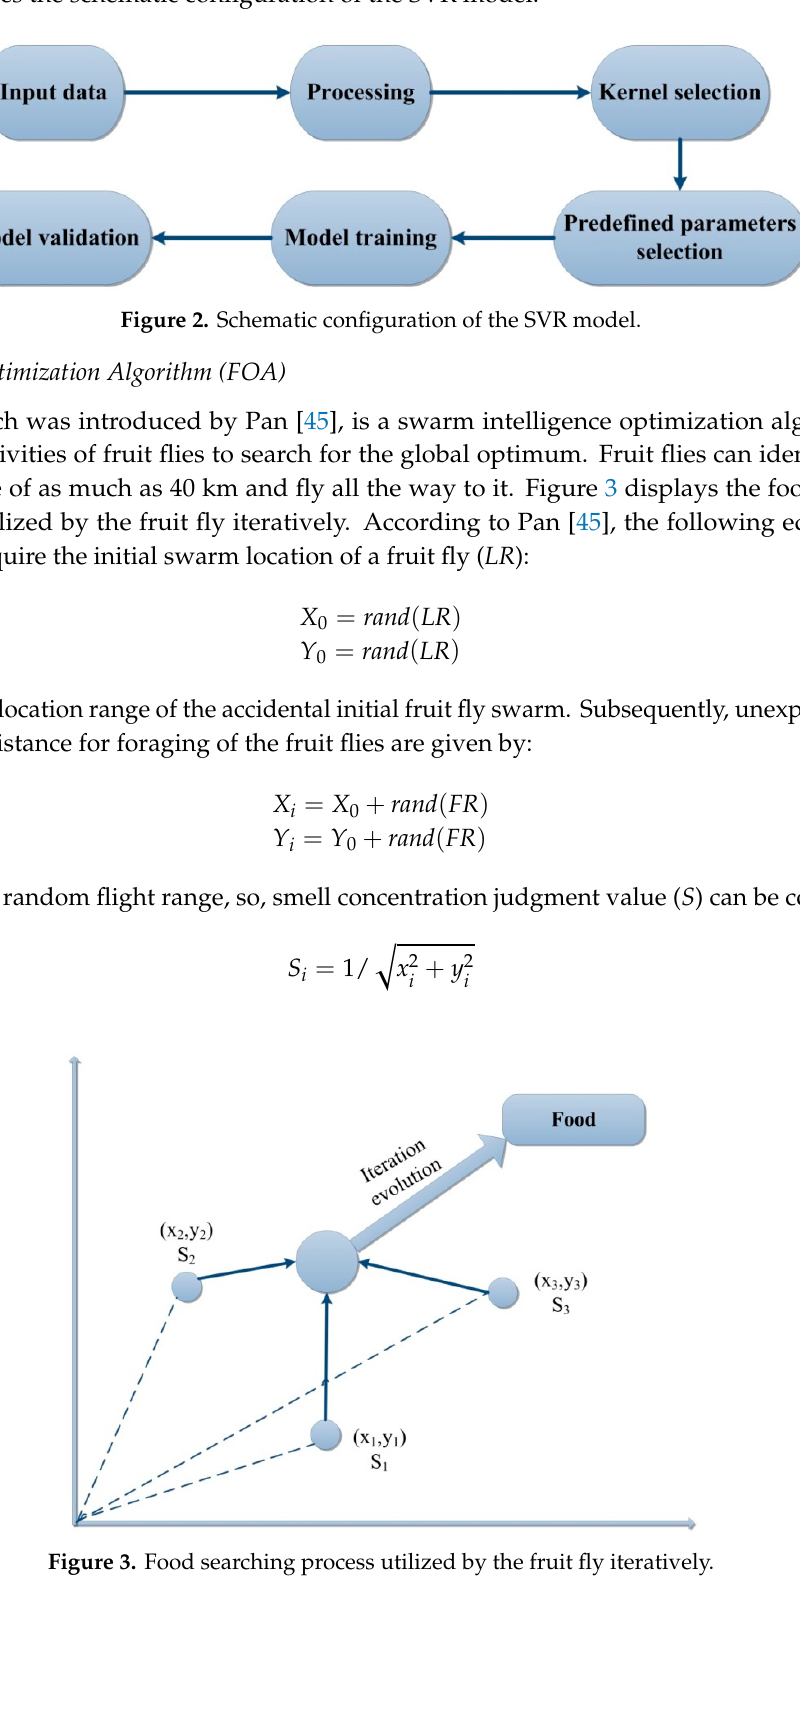
Figure 3. Food searching process utilized by the fruit fly iteratively.